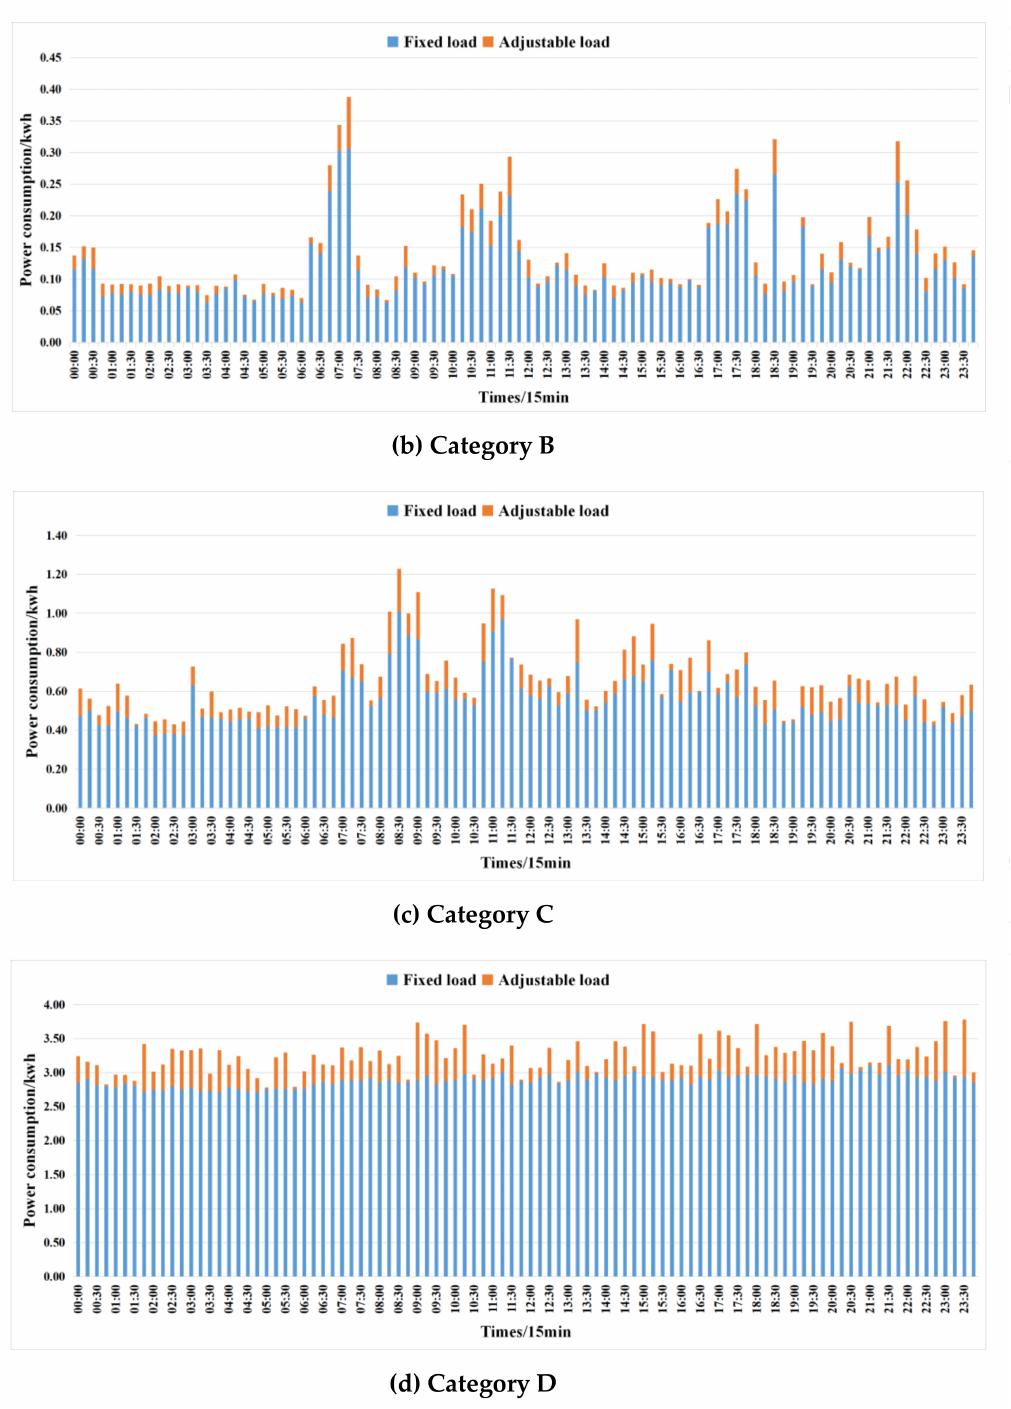
Figure 5. Electricity consumption curve of typical